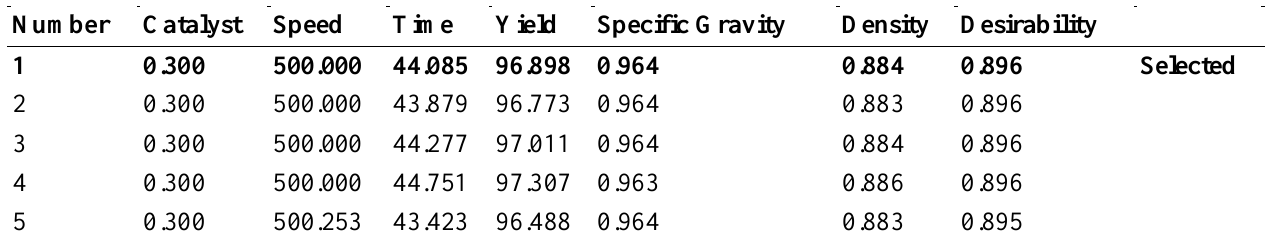
Table 13: Solutionsfor optimization